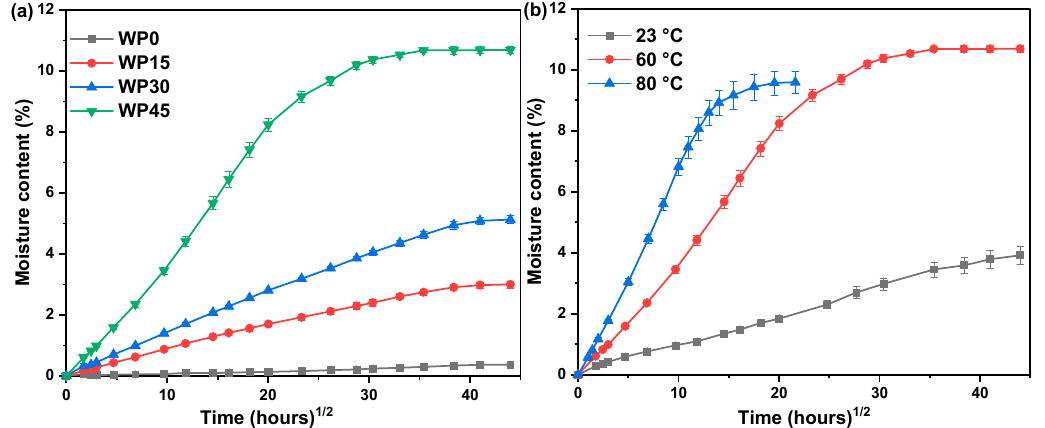
Figure 2. ( a ) Water uptake curves of different samples at a temperature of 60 °C, ( b ) water uptake curves of WP45 at different temperatures.